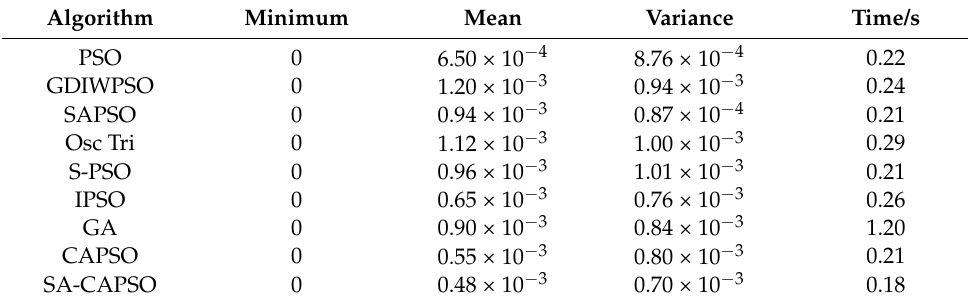
Table 11. Test results of test function